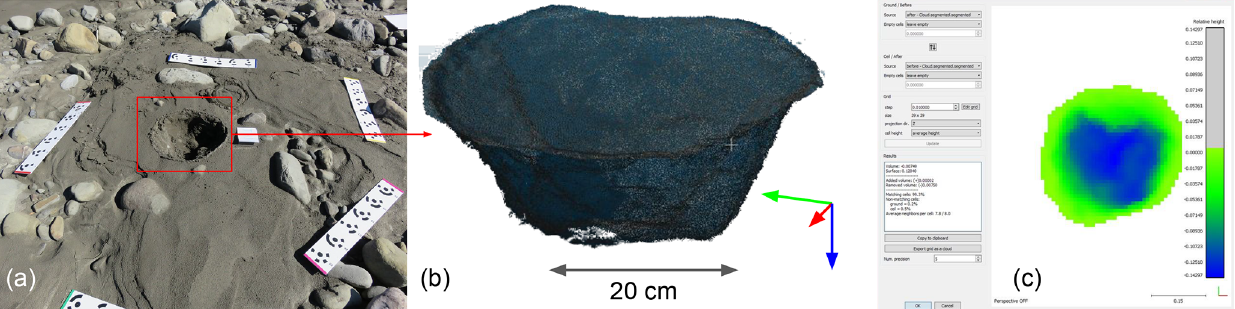
Figure C1. (a) Picture of the hole taken with references scales and benchmarks. Several pictures were thus taken before and after the hole was dug. (b) 3-D cloud of the points mapping the surface of the hole. (c) Computation of the volume bounded by the hole and the former surface of the ground before the hole was